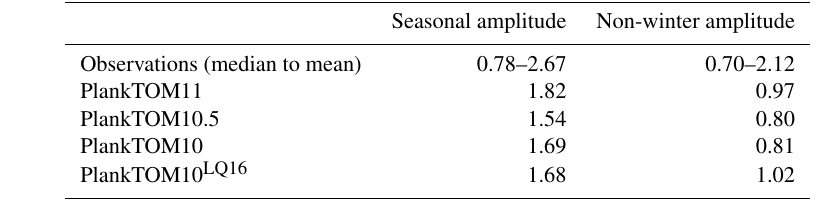
Table A6. Total phytoplankton biomass (µmolCL − 1 ) for 30–70 ◦ N across all longitudes. Observations are from gridded MAREDAT; all